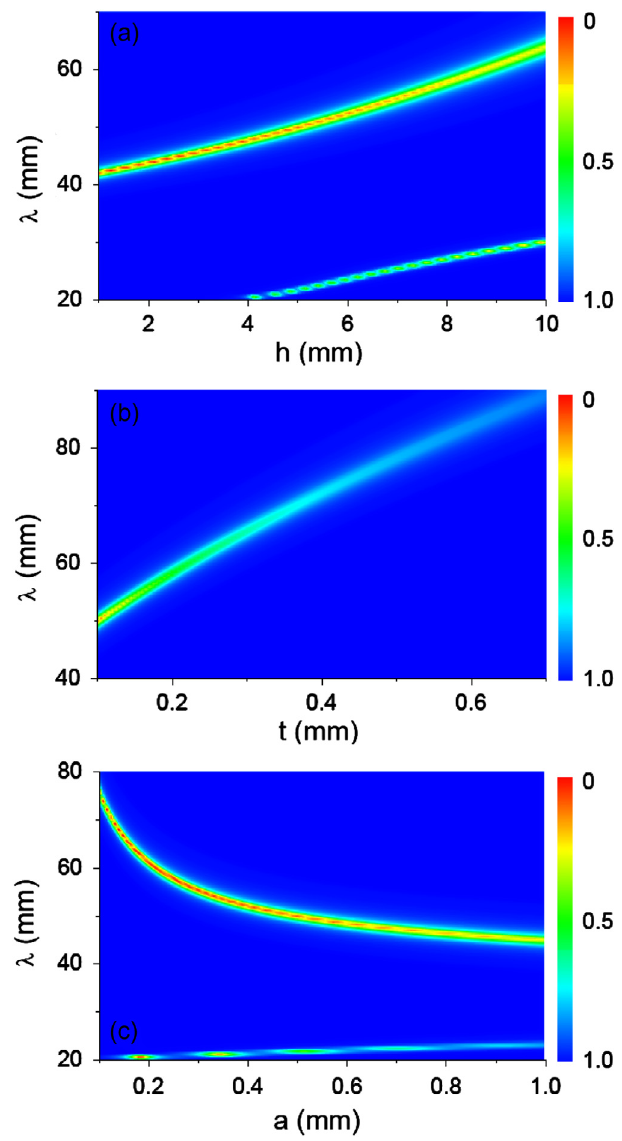
Figure 5. Reflection spectrum as a function of wavelength and structure sizes: (a) a = 0.5 mm, t = 0.1 mm; (b) a = 0.5 mm, h = 5 mm; and (c) h = 5 mm, t = 0.1 mm. The lattice constant is fixed as d = 20